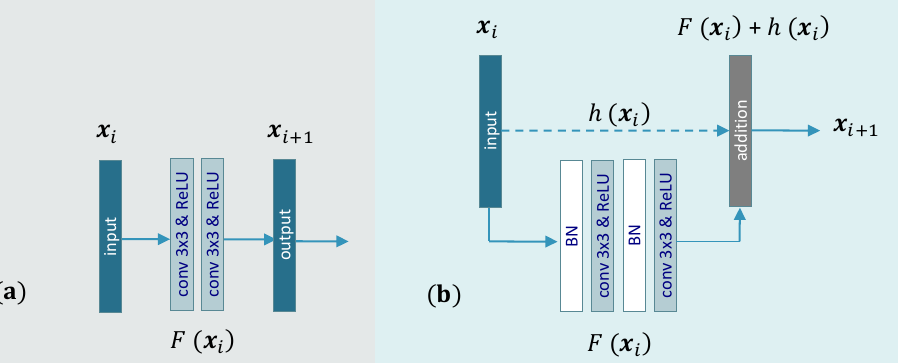
Figure 2. Illustration of the architecture of: ( a ) a typical convolutional process in a U-Net; and ( b ) a residual U-Net with an identity